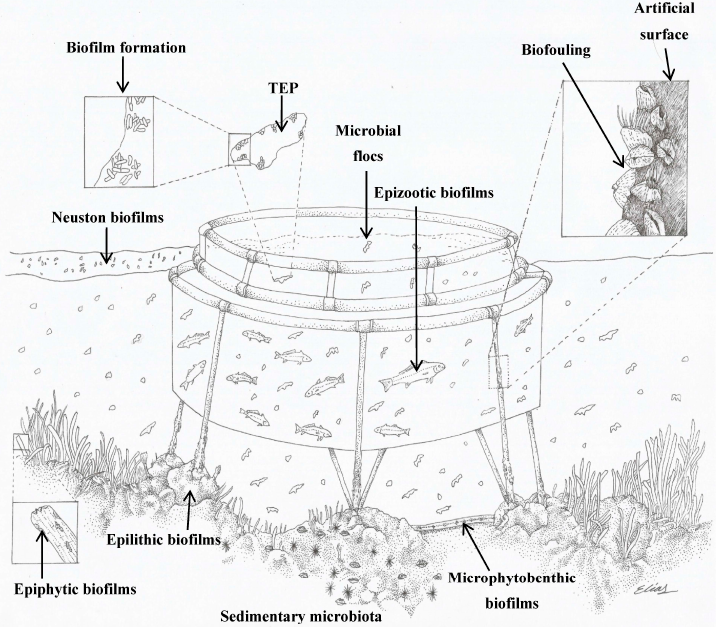
Figure 1. Diagram of a marine coastal aquaculture system depicting major microbial biofilm